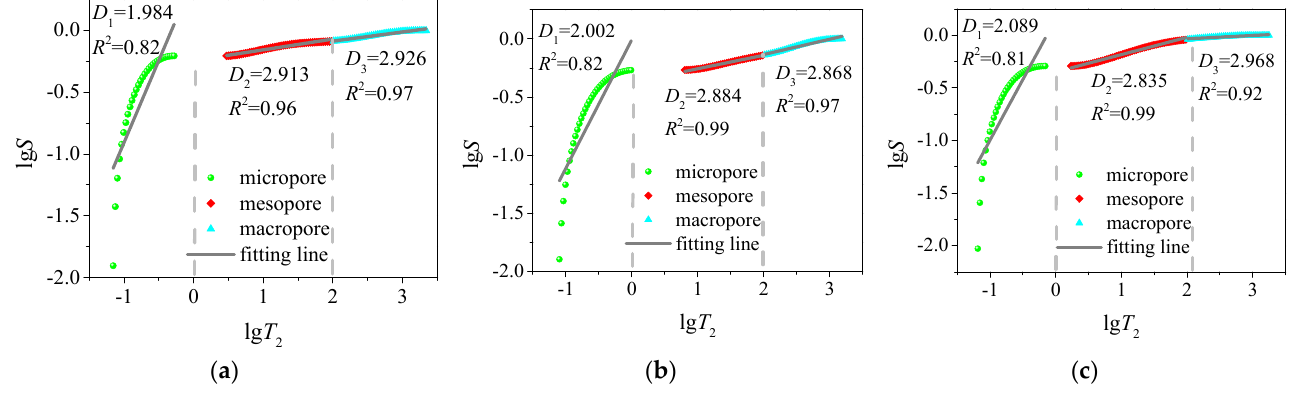
Figure 7. The calculation of multi-scale fractal dimensions, based on NMR. ( a ) N1, ( b ) N2, and ( c ) N3. The permeability contribution of capillaries or pores with the pore radius, r j ,